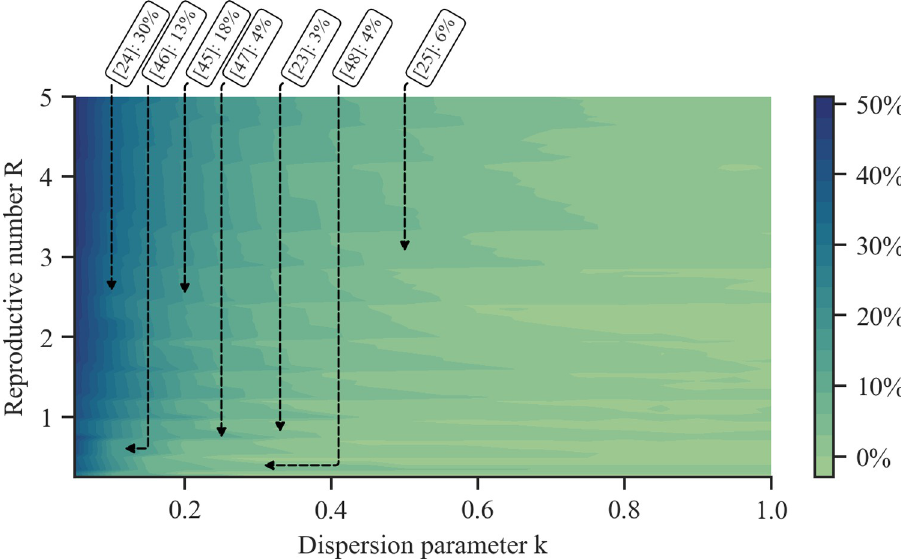
Fig 2. Percentage of tests saved by using our method instead of Dorfman’s method for different values of the reproductive number R and dispersion parameter k. Darker colors correspond to a higher average percentage of tests saved. To generate the contour, we evaluate the average percentage of tests saved using values in [0.25, 5.0] with step 0.05 for R and in [0.05, 1.0] with step 0.05 for k. The overlaid annotations indicate the average percentage of tests saved for several estimated values of the reproductive number and dispersion parameter reported in the COVID-19 literature [23–25,45–48]. Here, we set the number of contacts to N = 100 and the sensitivity and specificity to s e = 0.8, s p = 0.98. In each experiment we estimate the average using 10,000